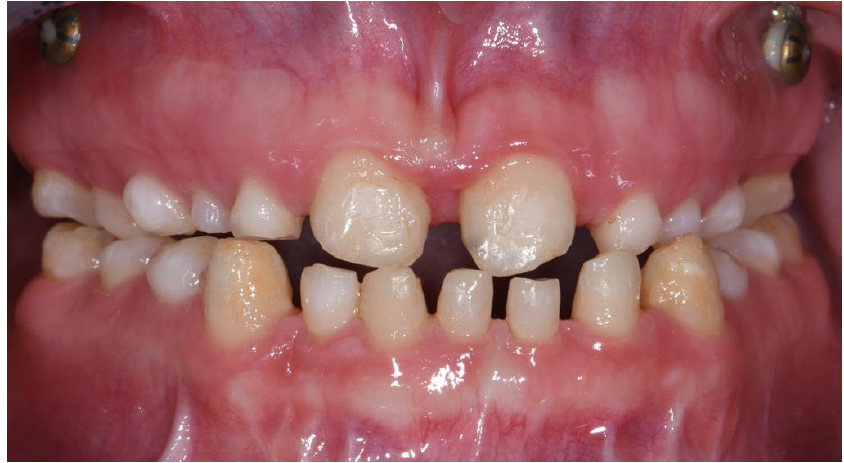
Figure 13. Case 4—Dental arches of a young patient with multiple dental agenesis.